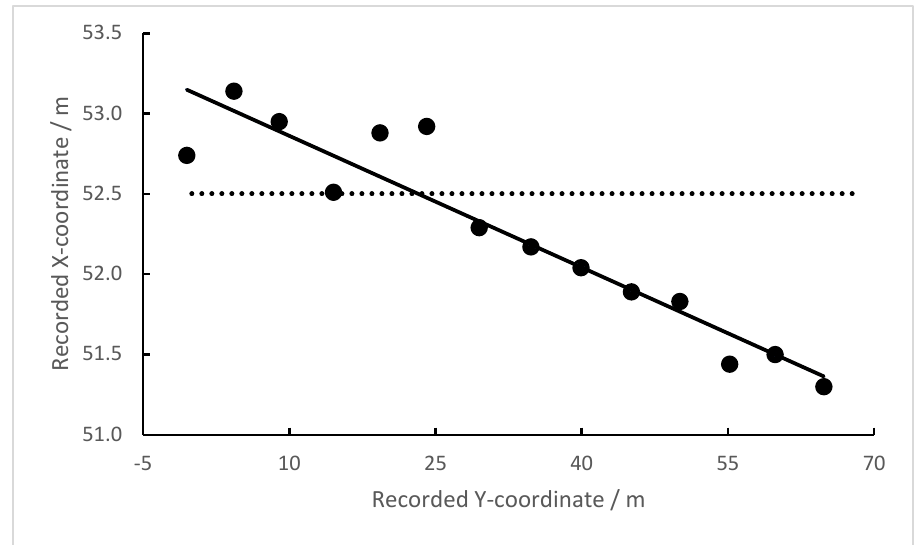
Figure 5. Recordings of the x ‐ coordinate of transponders lying on the ground along the field’s midline. The dashed line is the known x ‐ coordinate.